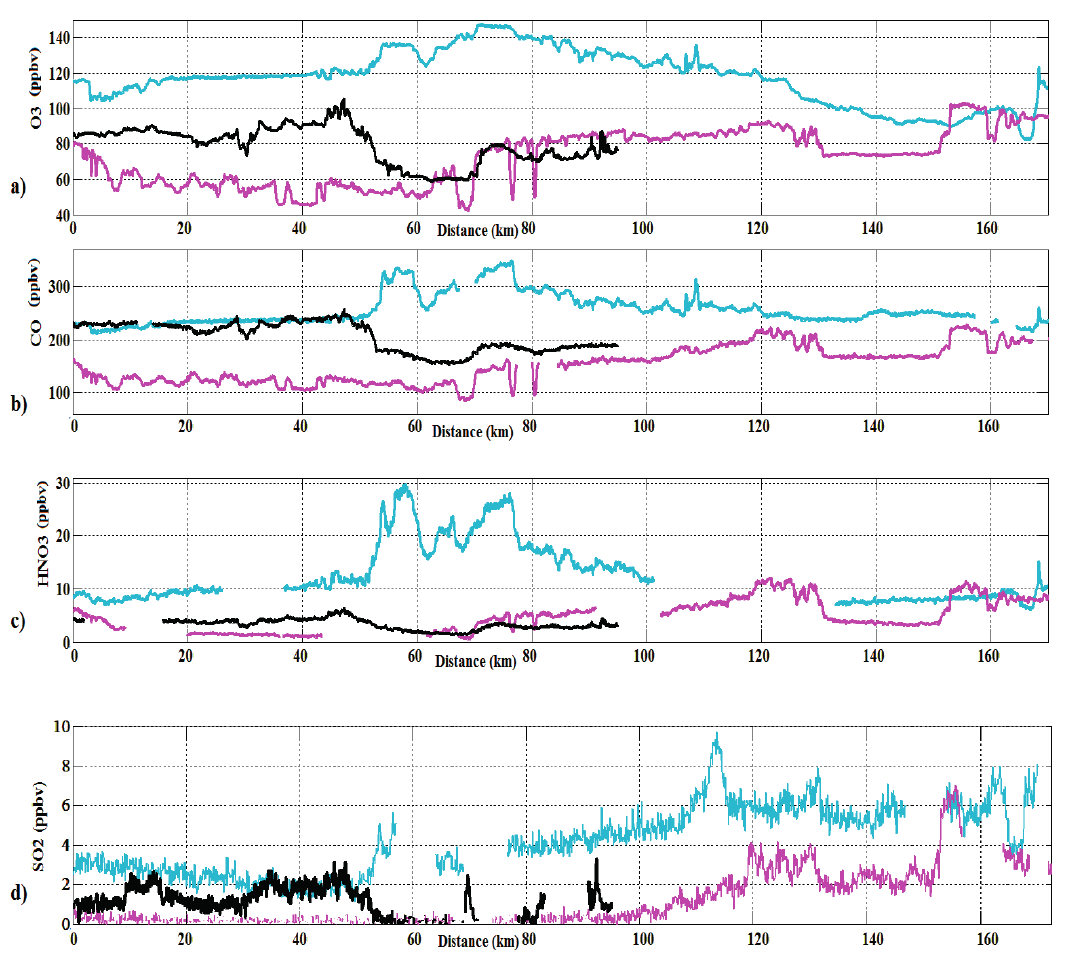
Cyan lines designate the coastal GOM transects and magenta lines the open ocean GOM transects on 7/21. Black lines designate observations made during a transect over the central GOM on